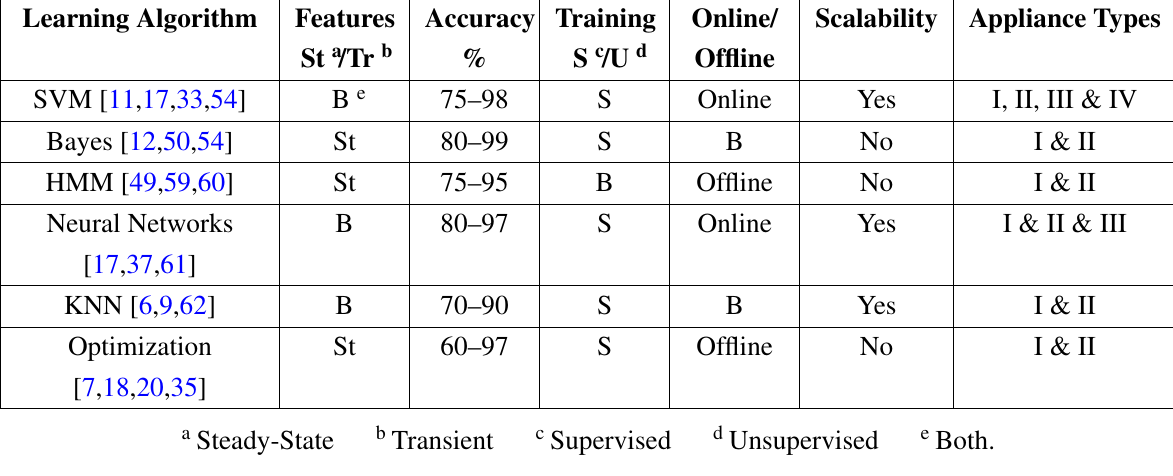
Table 3. Comparison of load disaggregation